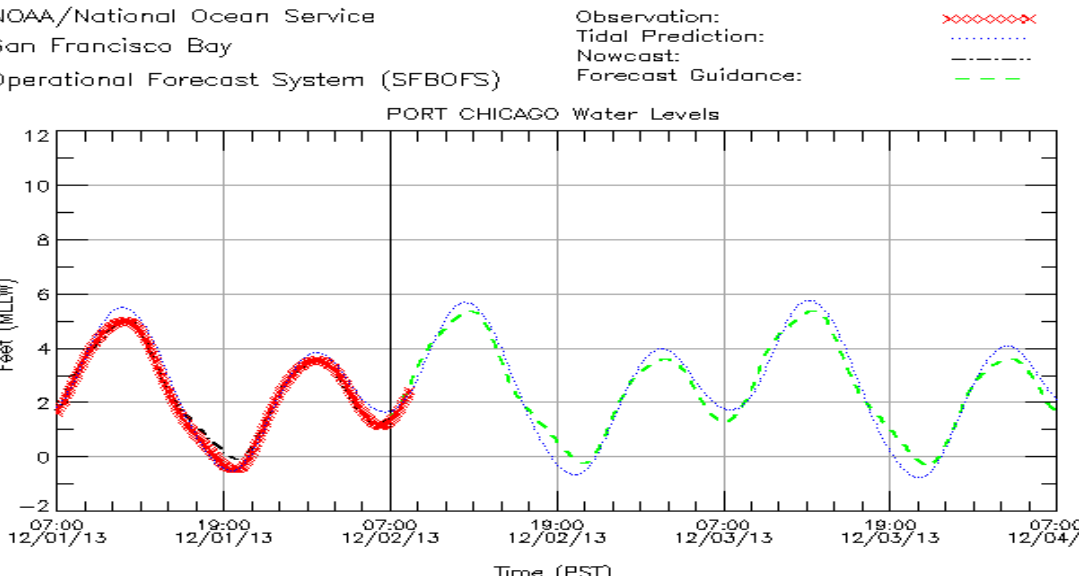
Figure 12. The nowcast/forecast versus observed water levels at Port